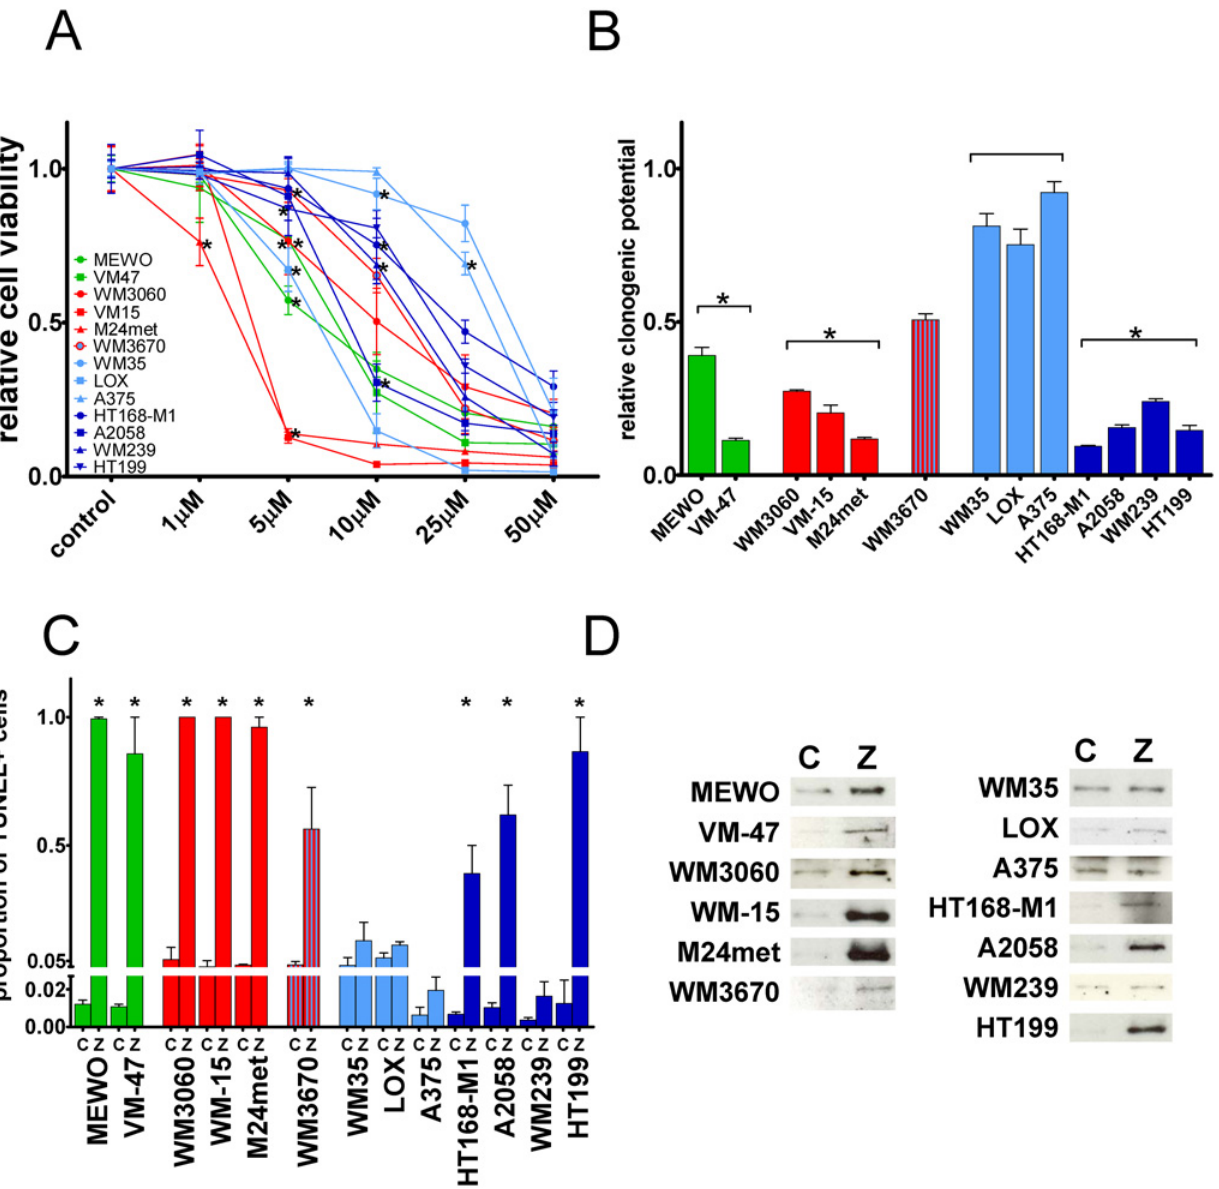
Fig 1. Cell viability, clonogenic growth and apoptosis in melanoma cells after zoledronic acid treatment. ( A ) Dose-response analysis of cell viability of human melanoma cell lines with different mutations after 72hs treatment with ZA measured by SRB assay; Most pronounced reduction in cell viability was observed in two NRAS mutant lines ( B ) Long-term effect of 10 days of 5 μ M ZA treatment on clonogenic growth. Resistance was found in BRAF mutant and PTEN wild-type cells. Of note, NRAS and BRAF double mutant cells demonstrated intermediate sensitivity ( C ) Apoptosis induction after 25 μ M ZA treatment demonstrated by the proportion of TUNEL positive cells and ( D ) apoptosis induction of 72hs ZA treatment evaluated by the immunoblot of cleaved PARP. Limited apoptosis induction was found in BRAF mutant and PTEN wild-type cells and in the MDM2 over expressing WM239 cells. Colors green, red, blue, and dark-blue indicate triple wild-type, NRAS, BRAF, and BRAF mutant/PTEN-null mutational status of the cells, respectively. Data shown as average ± SEM are from at least 5 repeats. Asterisks indicate the lowest concentration of ZA treatment resulting in a significant difference with p < 0.05 from control by ANOVA and Dunnett ’ s post hoc test in the cell viability assay. Data shown as average ± SEM are from at least 3 measurements. Asterisks indicate significant difference of p < 0.05 between given mutational group and the BRAF mutant PTEN wild-type group by Kruskal-Wallis and Dunn ’ s post hoc test in the clonogenic assay, and p < 0.05 difference from the respective control by unpaired two tailed T test in the apoptosis assay. (C = control; Z = zoledronic acid).